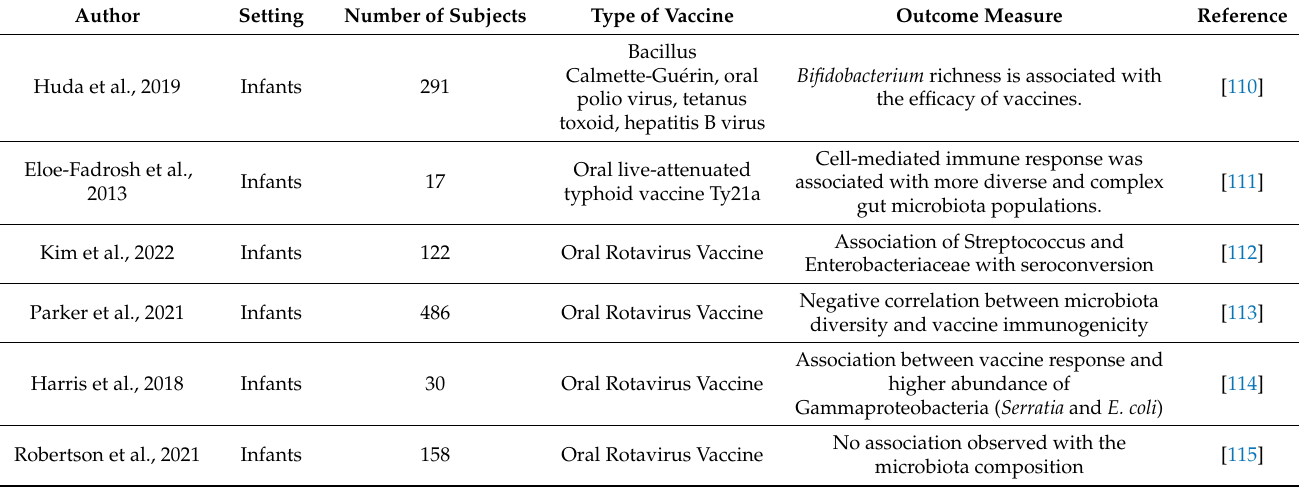
Table 1. Microbiota composition and response to